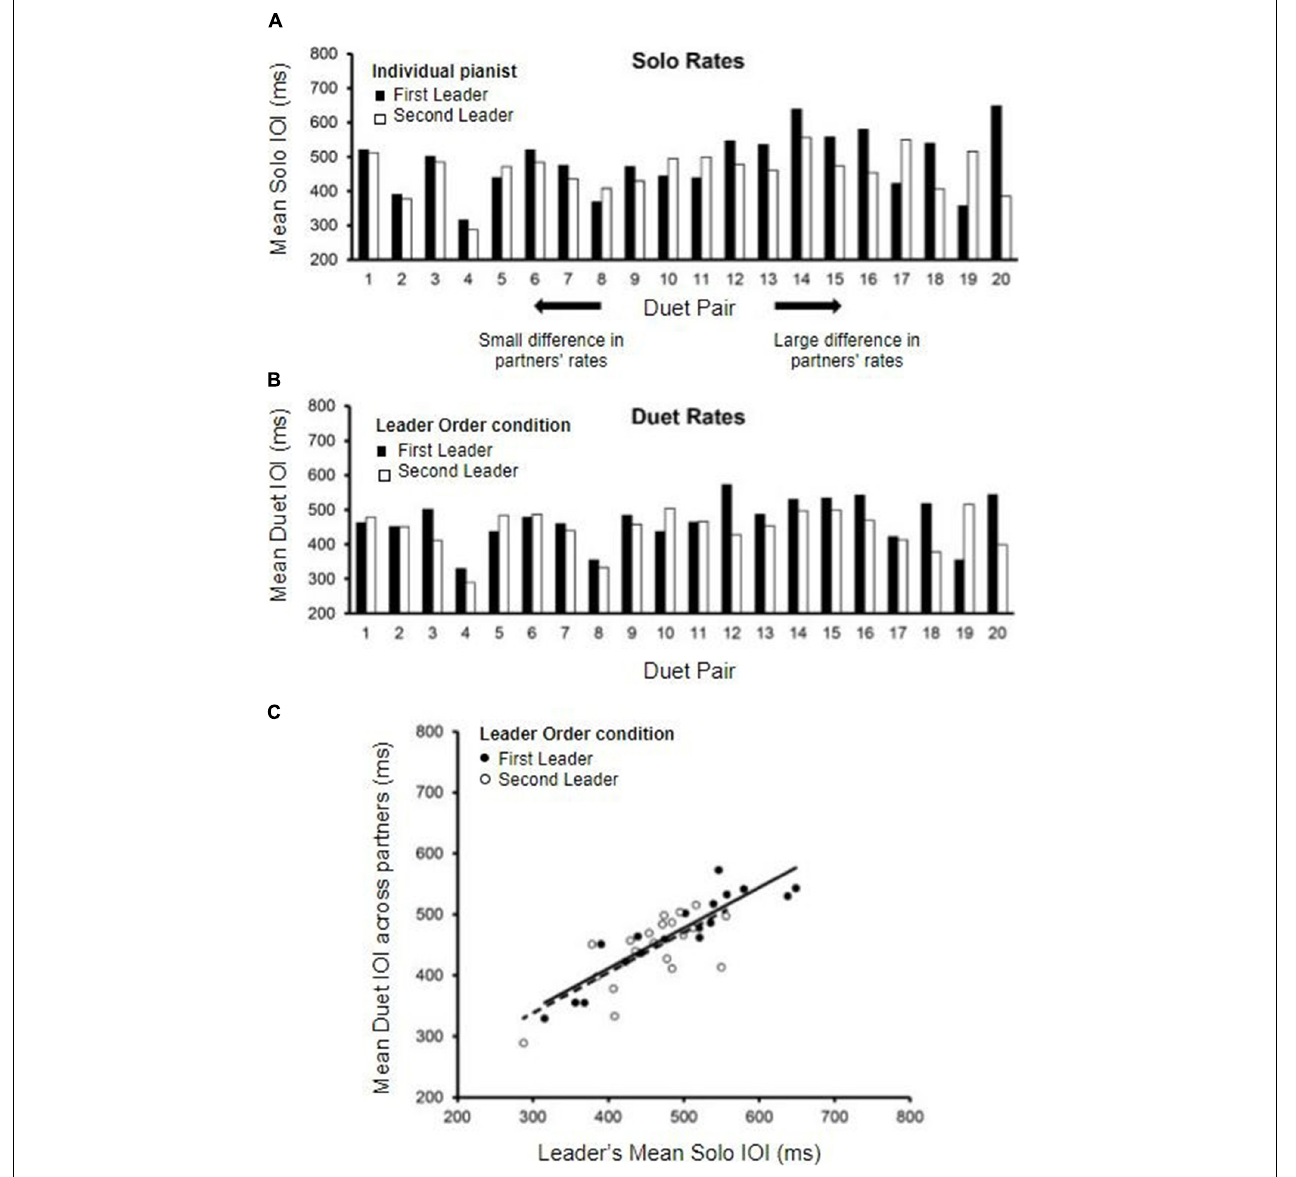
FIGURE 2 | Solo and Duet performance rates. (A) Mean Solo performance rates for individual partners; partners are labeled by who served as Leader in the First-Leader (black bars) and Second-Leader (white bars) Duet conditions. Pairs are ordered by the magnitude of difference in partners’ Solo rates (smallest difference on the left, largest on the right). (B) Mean Duet performance rates for each pair (averaged across partners) in the First-Leader (black bars) and Second-Leader (white bars) conditions. Pairs are ordered the same as in panel (A) , by the magnitude of difference in partners’ Solo rates. (C) Leaders’ mean Solo performance rates (x-axis) correlated with Mean Duet performance rates (y-axis) in the First-Leader (black dots) and Second-Leader (white dots) conditions, with trend lines (solid = First-Leader condition; dashed = Second-Leader condition). Each dot represents data from one